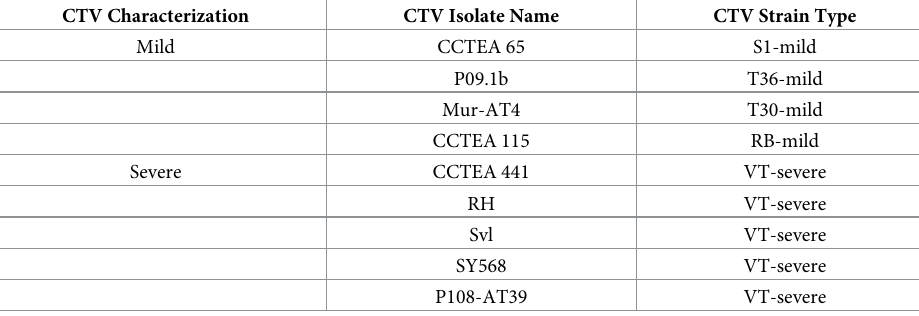
Table 1. Mild and severe CTV strains utilized in this